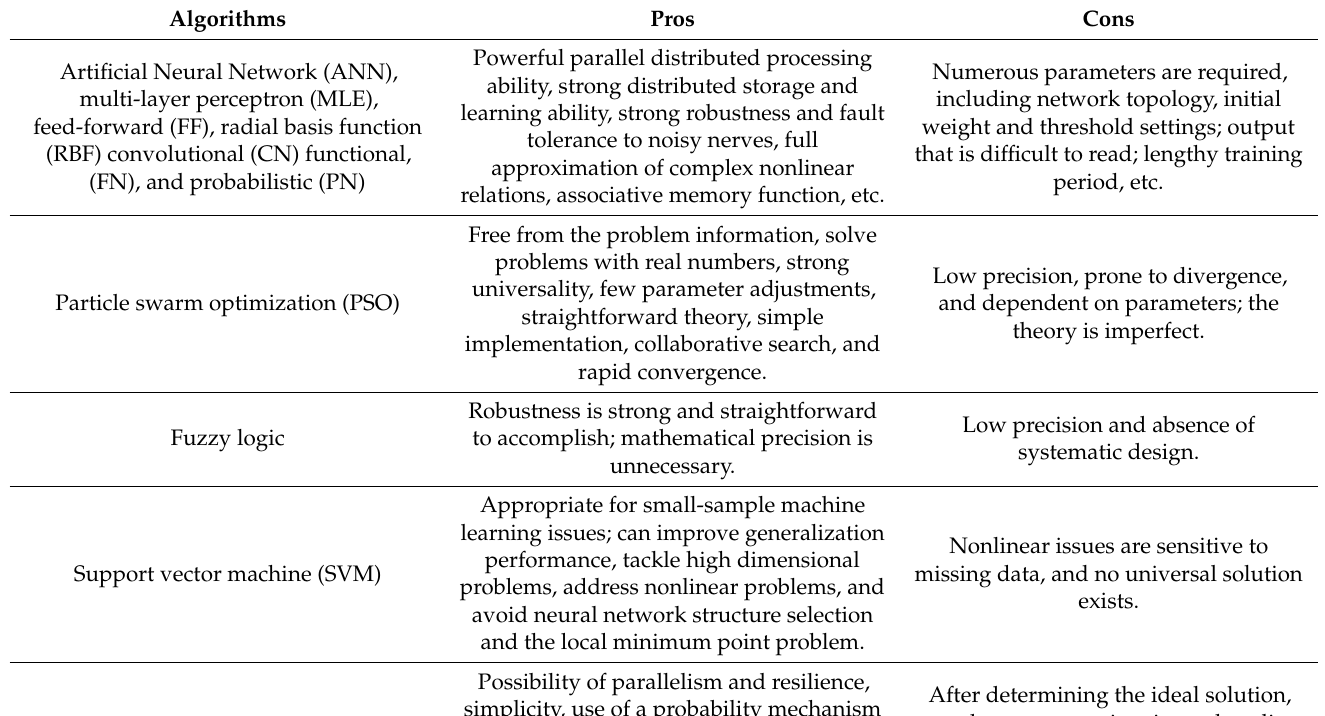
Table 7. The pros and cons of commonly used algorithms in the oil and gas field Adapted from Li et al.